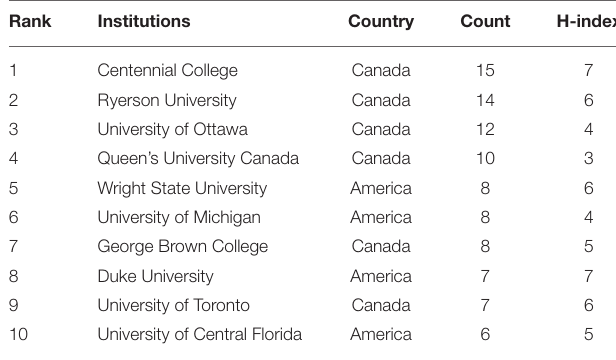
TABLE 1 | The top 10 countries or regions with publications on the application of VR in nursing from 2012 to 2021.